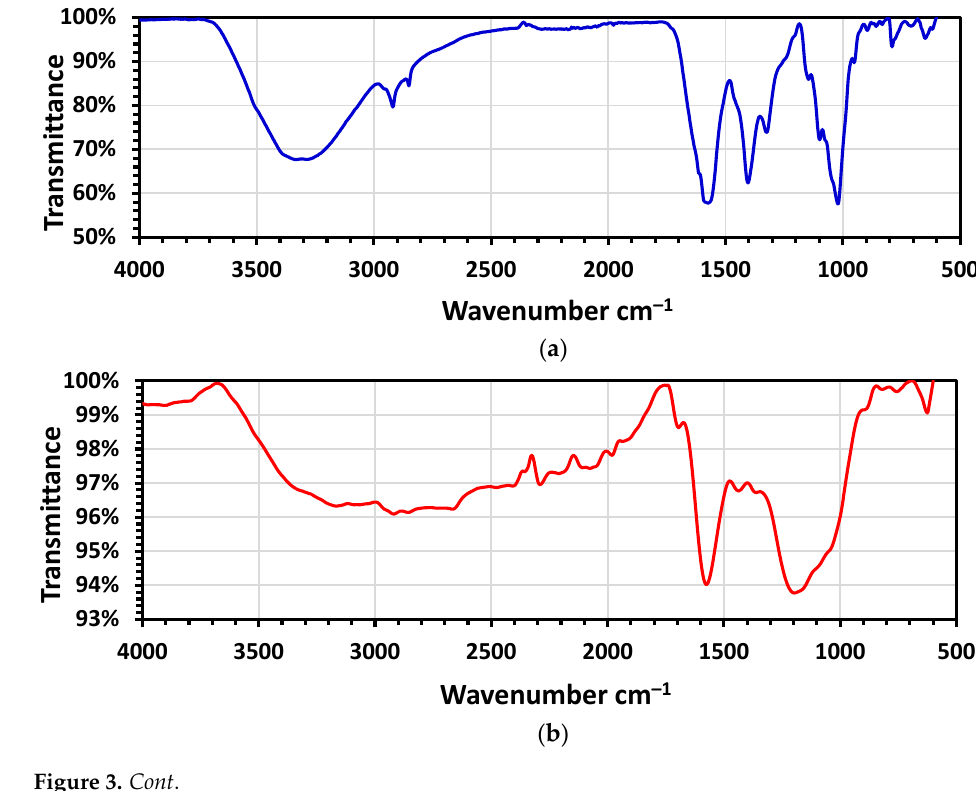
( c ) Figure 3. FTIR analysis of ( a ) raw Pea pods–KOH, ( b ) AC-KOH/N 2 /800 °C, ( c ) AC-KOH/CO 2 /800 °C. 2.2.3. Scanning Electron Microscopy (SEM) Figure 4a–f shows the SEM images of the microstructure of the Pisum sativum pods, which were impregnated with a 2:1 ratio of ZnCl 2 and activated at different temperatures (600, 700, and 800 °C) under CO 2 gas for 60 min. It can be seen from SEM images taken during the activation stage (700 °C) that several porous and hollow carbon holes were observed on the activated carbon ’ s surface. The external surface of the activated carbon has a porous structure with a large number of micropores because the most volatile organic materials evolved. Micrographs (~nm range) of activated carbon taken during experiments performed at carbonization temperatures 600 and 800 °C exhibit an extensive external surface with a very high number of micropores with diameters ranging from 69.95–48.88 nm, which act as channels for the microporous adsorbent. Obviously, activated carbon processes were successful, and the microporous structure was developed by chemical activation process with ZnCl 2 , so it had a large specific surface area, which was consistent with the BET value.